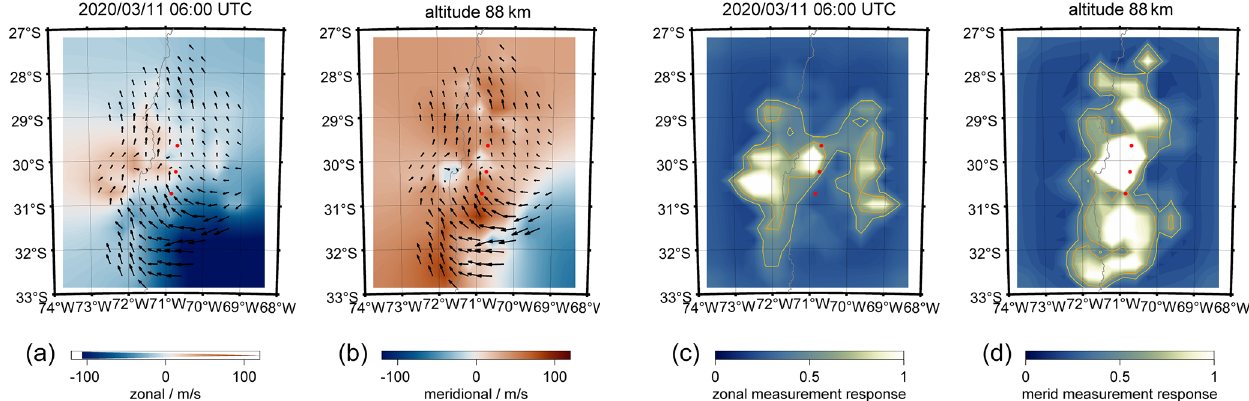
Figure 5. Panels (a) and (b) show the color-coded zonal and meridional wind strength. Bluish colors indicate southward and westward motions; reddish colors highlight northward or eastward winds. Black arrows show the wind direction centered at each grid cell. Panels (c) and (d) show the color-coded measurement response for the zonal and meridional wind components.